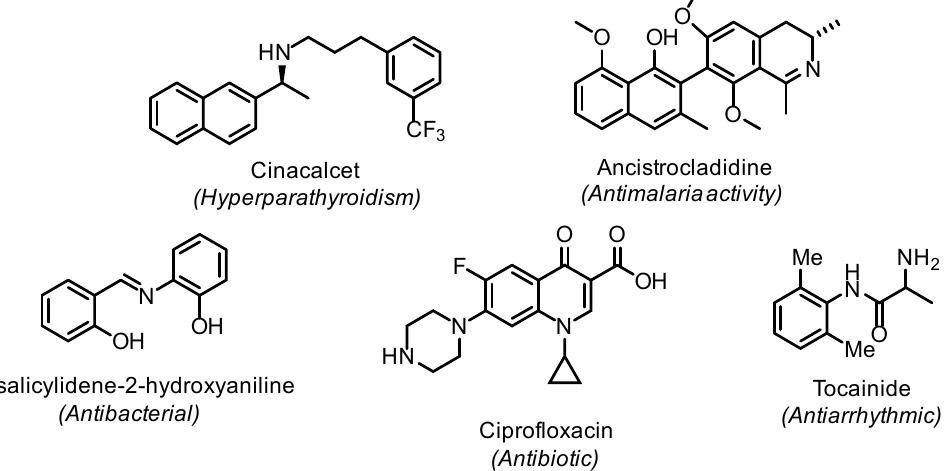
Figure 1. Selected example of biologically active compounds containing amine, imine, or enamine functionalities.